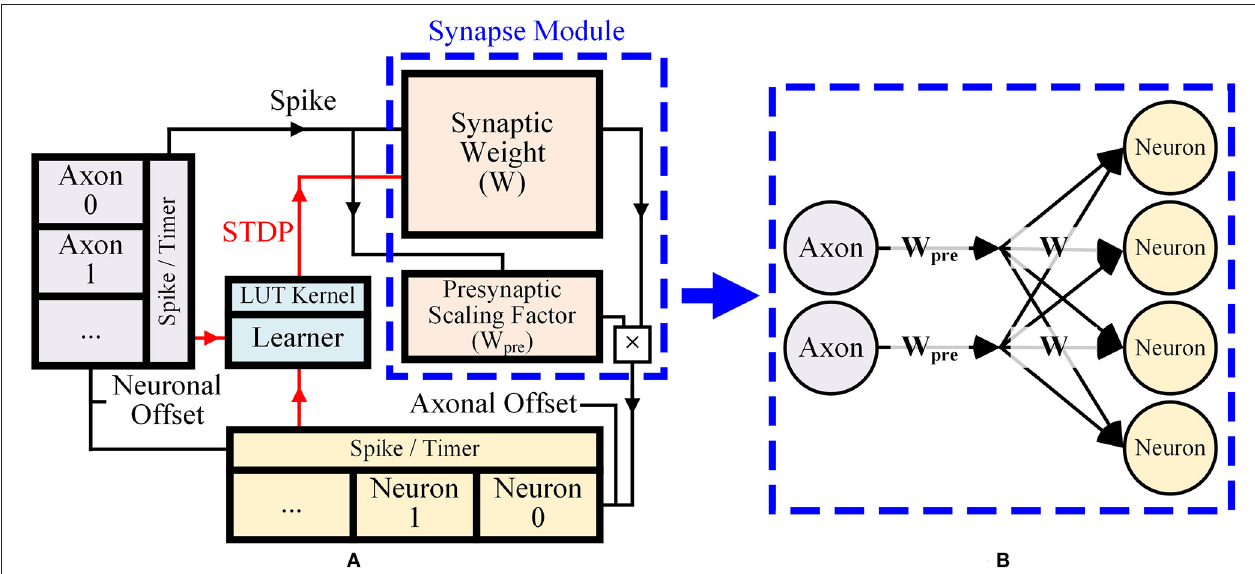
FIGURE 1 | (A) Overall dataflow of the proposed design, (B) Presynaptic weight scaling